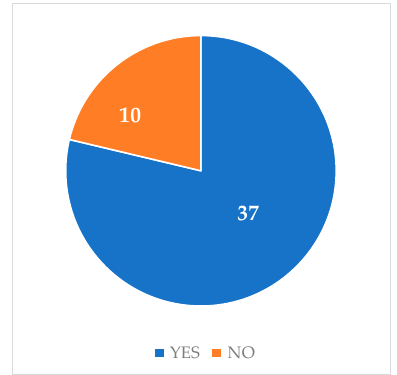
Figure 8. Questionnaire results regarding students’ interest in the game.